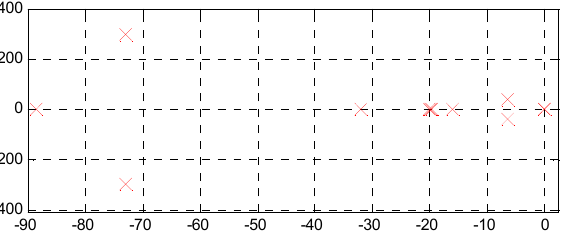
Figure 8. The root locus diagram of the parameters used in the experiment.